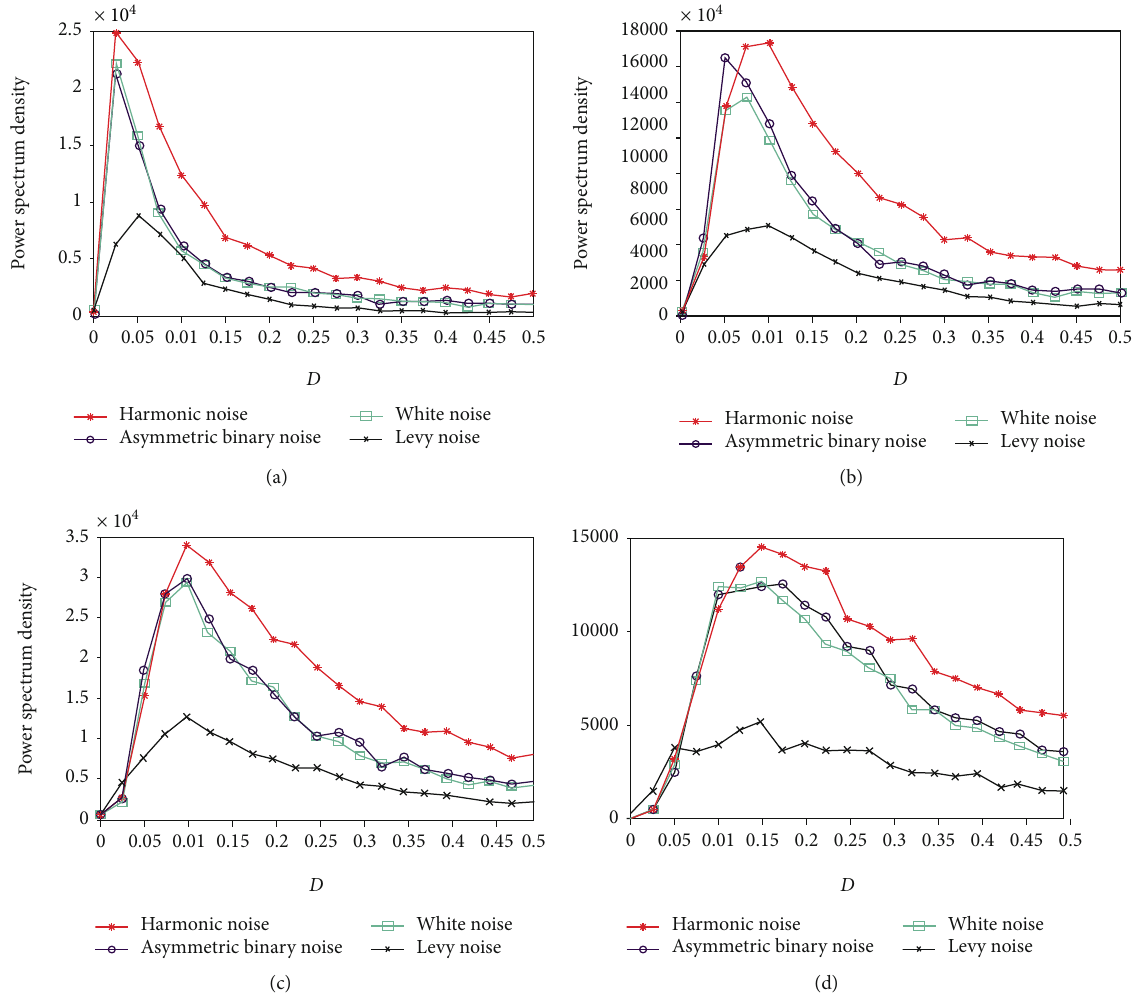
Figure 8: The relational graph between noise intensity D and system output of undamped bistable system driven by four noise. (a) The output when the damping coe ffi cient of the bistable system is η = 0 : 2 . (b) The output when η = 0 : 5 . (c) The output when η = 0 : 7 . (d) The output when η = 1 : 0